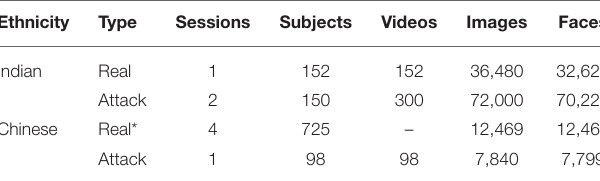
TABLE 1 | Characteristics of the proposed NIR face presentation attack database.